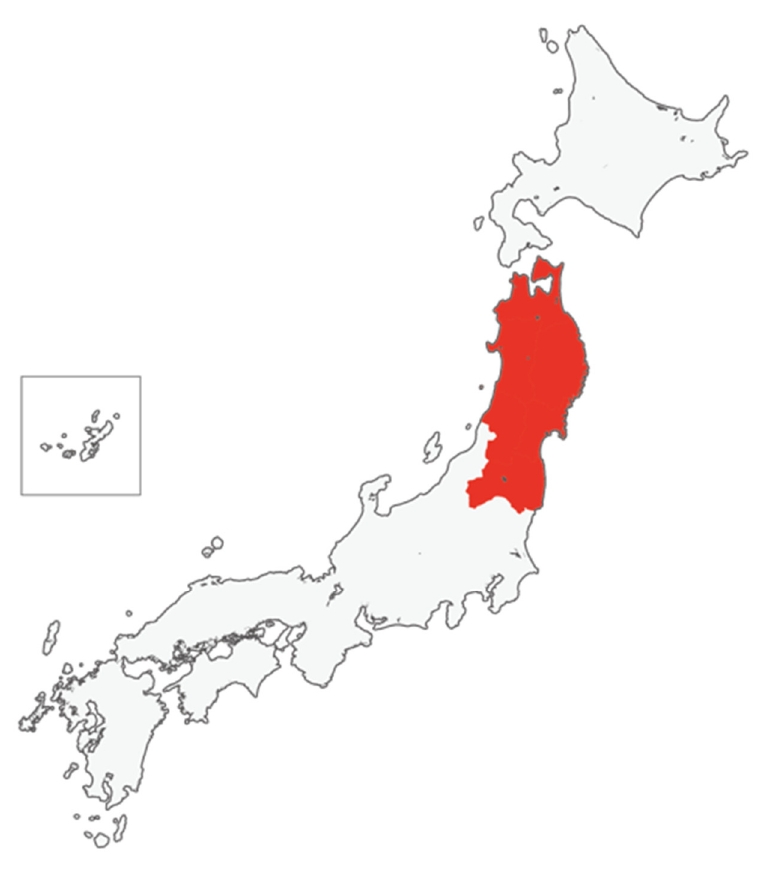
Figure 4. Location of the Tohoku region in